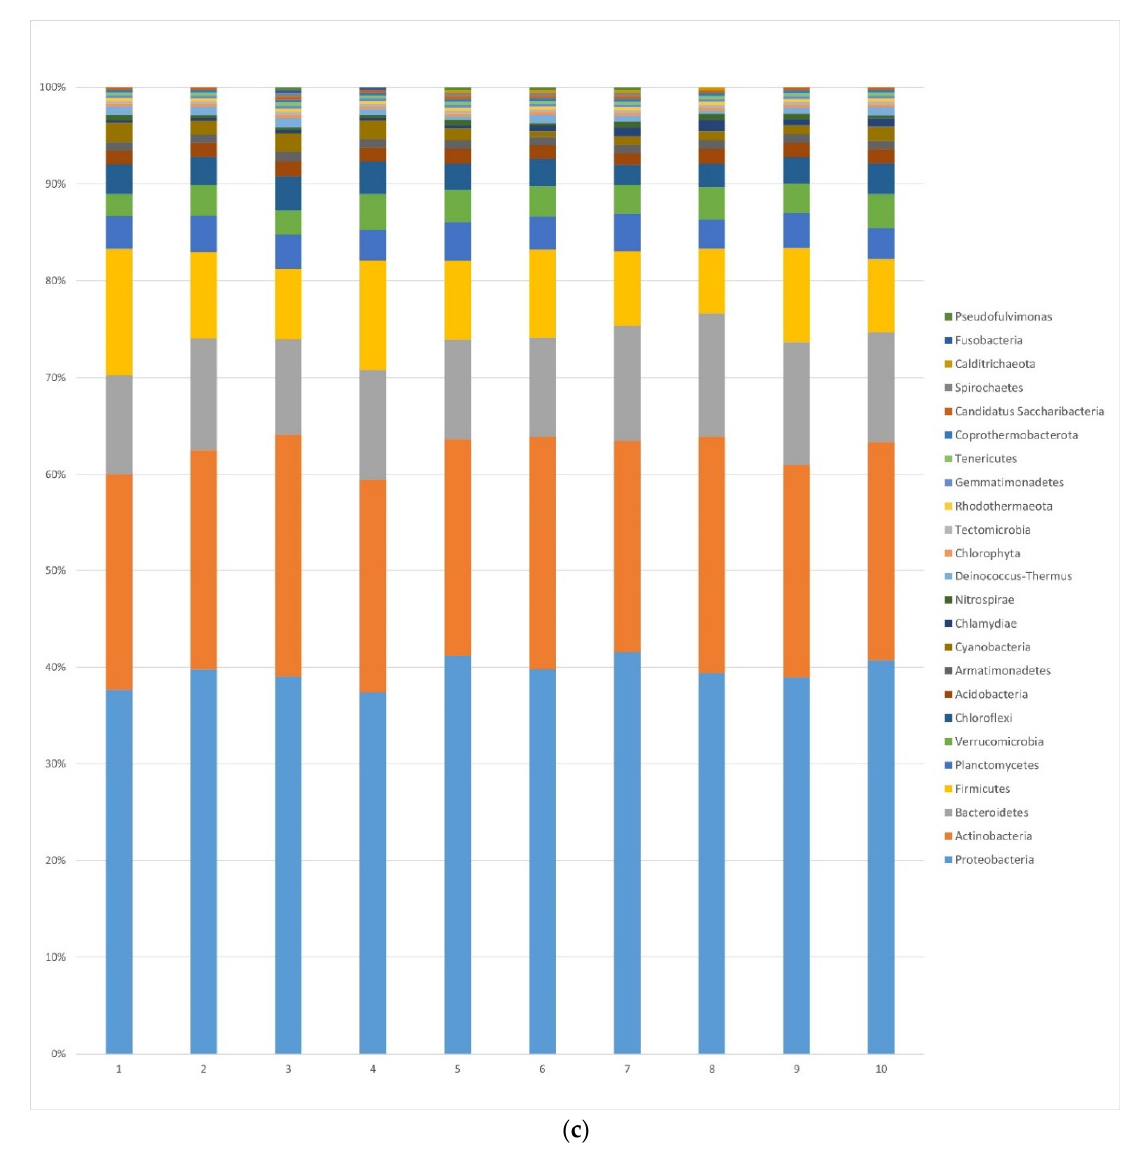
Figure 3. ( a ) Bacterial richness, number and proportional distribution of the 3392 bacterial OTUs representing all the detected taxonomic phyla. ( b ) Classes of the phylum Proteobacteria and their number and proportional distribution. ( c ) Bacterial richness by sample.